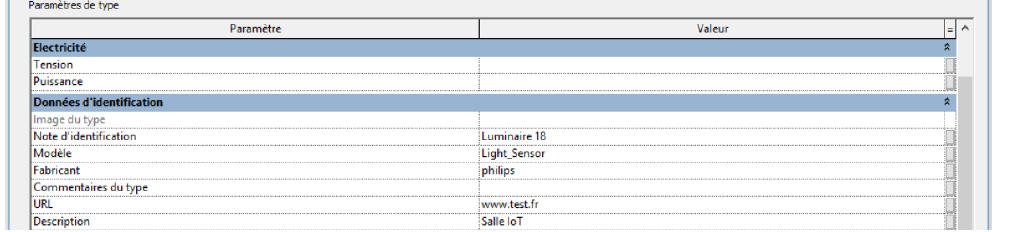
Figure 5. Sensor data used during the validation process: a screenshot of the BIM modelling platform.